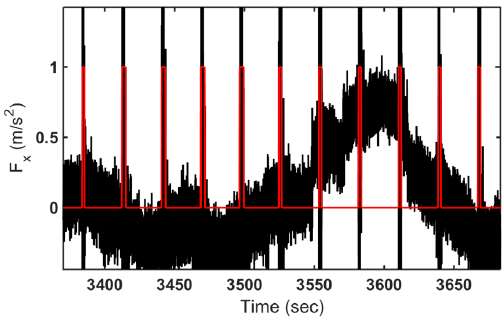
Figure 7. Pattern detected using WL.